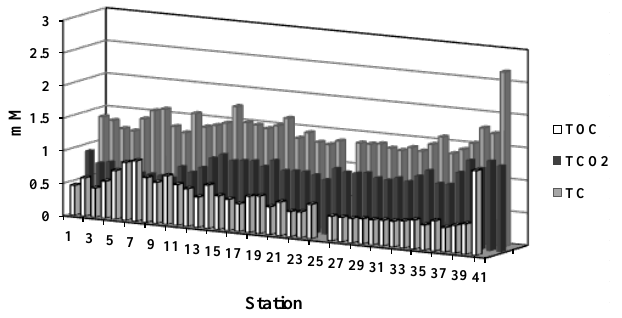
Fig. 6. Distribution of measured TOC (mM), TCO 2 (mM), and TC (mM) along the Lena River from Yakutsk to Tiksi (late August– early September 1995). Table 2. Mean concentrations of TOC, TCO 2 , and TC obtained along the Lena River (from Yakutsk to the Laptev Sea), and Lena River discharge (W) in August of different